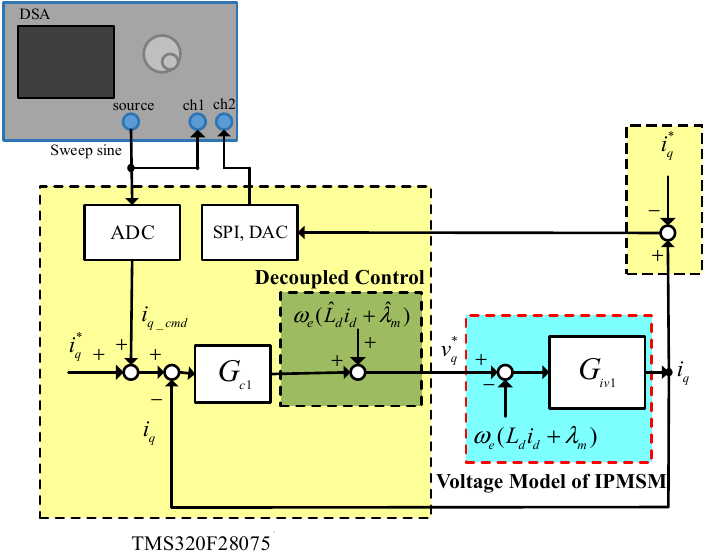
Figure 9. Bode plots measuring scheme of q -axis current control loop by using DSA.